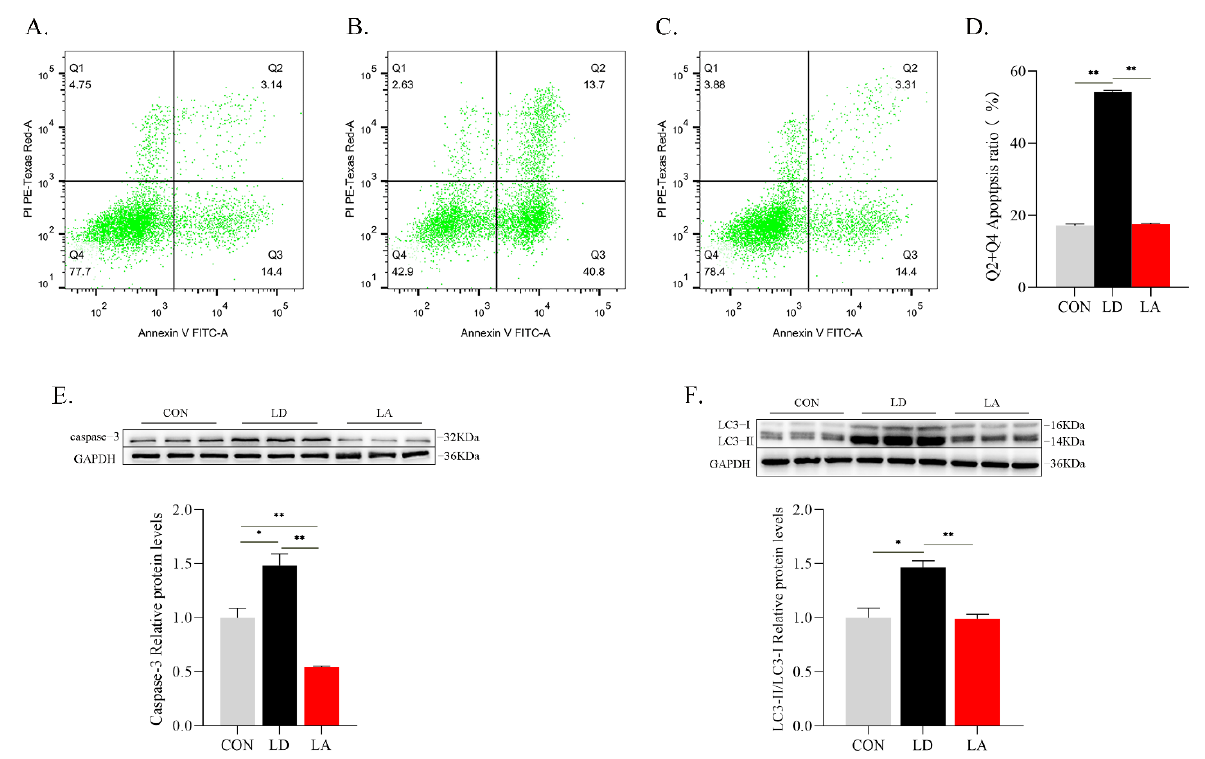
Figure 4. Lysine deficiency causes SCs cycle arrest. ( A ) CON; ( B ) LD; ( C ) LA; ( D ) G1 phase cell ratio (%); ( E ) G2 phase cell ratio (%); ( F ) S phase cell ratio (%). * p < 0.05, ** p < 0.01. The data shown represent mean ± SEM of three independent experiments ( n = 3).